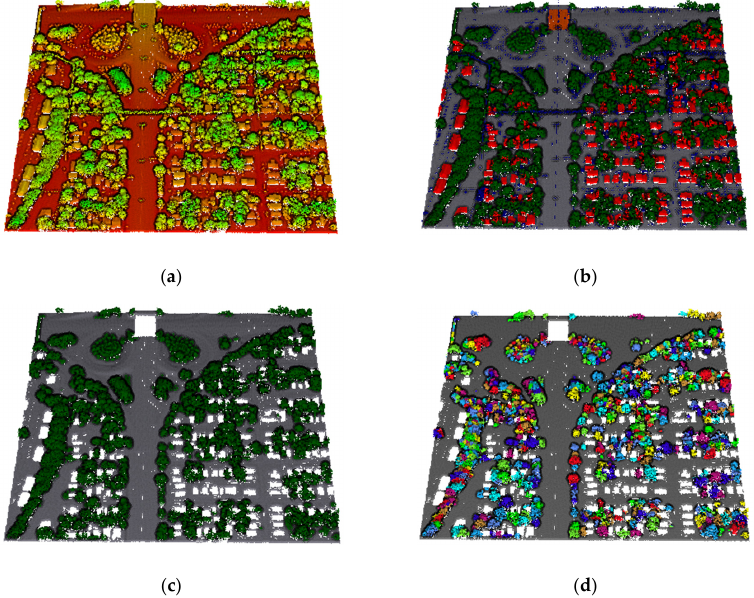
Figure 11. Detailed results from selected area 1 of DFC 3D dataset. ( a ) the original point clouds; ( b ) the classification result; ( c ) the roadside trees extraction; ( d ) the roadside trees segmentation.